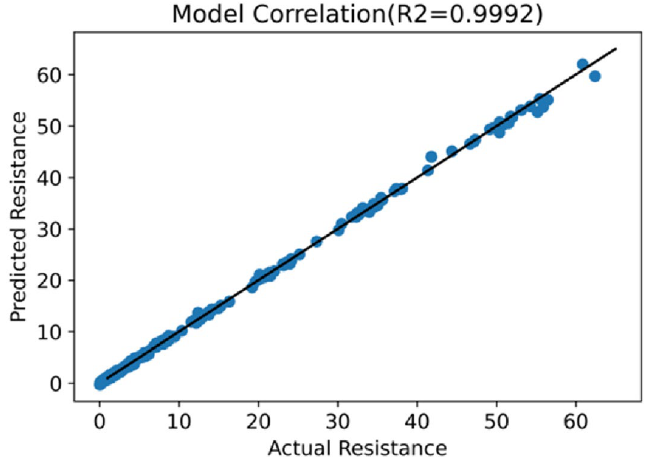
Fig. 13 Actual vs predicted for the yatch hydrodynamics ANN